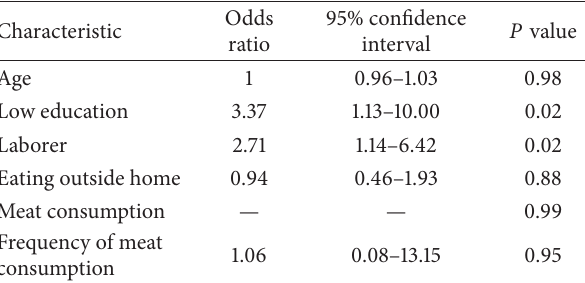
Table 3: Multivariate analysis of selected characteristics of Tepe- huanos and their association with H. pylori